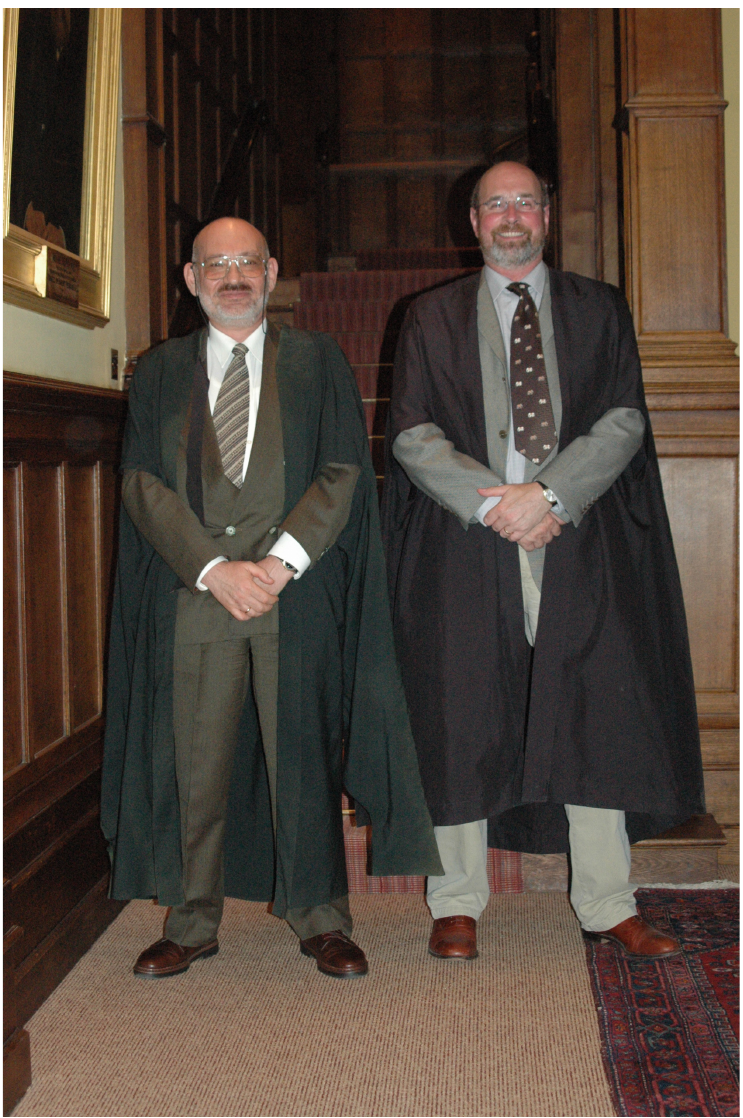
Figure A1. Michael Tribelsky ( left ) and Michael Proctor ( right ): Trinity College, Cambridge, UK in